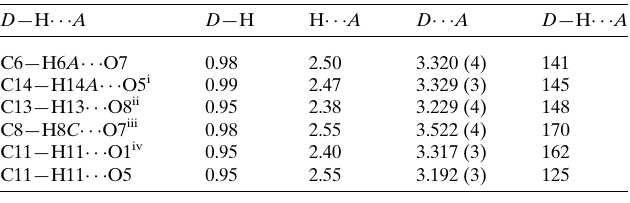
Table 3 Hydrogen-bond geometry (A˚ , (cid:5) ) for 2 .